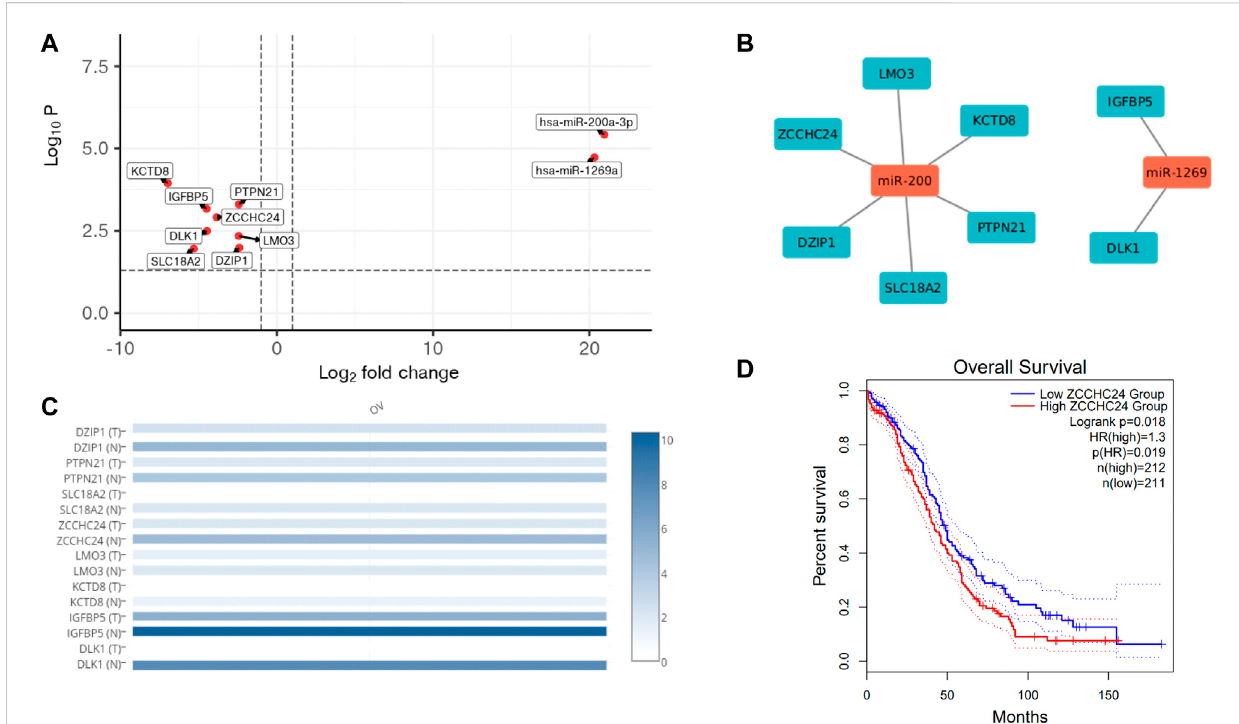
FIGURE 4 miRNAanalysisofHGOSCsamplesinthecohort. (A) .UpregulatedmiRNAsandtheirtargetsinOVCaHGSOCsamples. (B) .Geneinteractionnetwork of miRNAs and their target genes. (C) . Expression of miRNA targets in the OVCa TCGA data show similar pattern as observed in our samples. (D) . Kaplan Meier plot of ZCCHC24 (miR-200 target), signifying survival probability between high vs. low expressed groups from